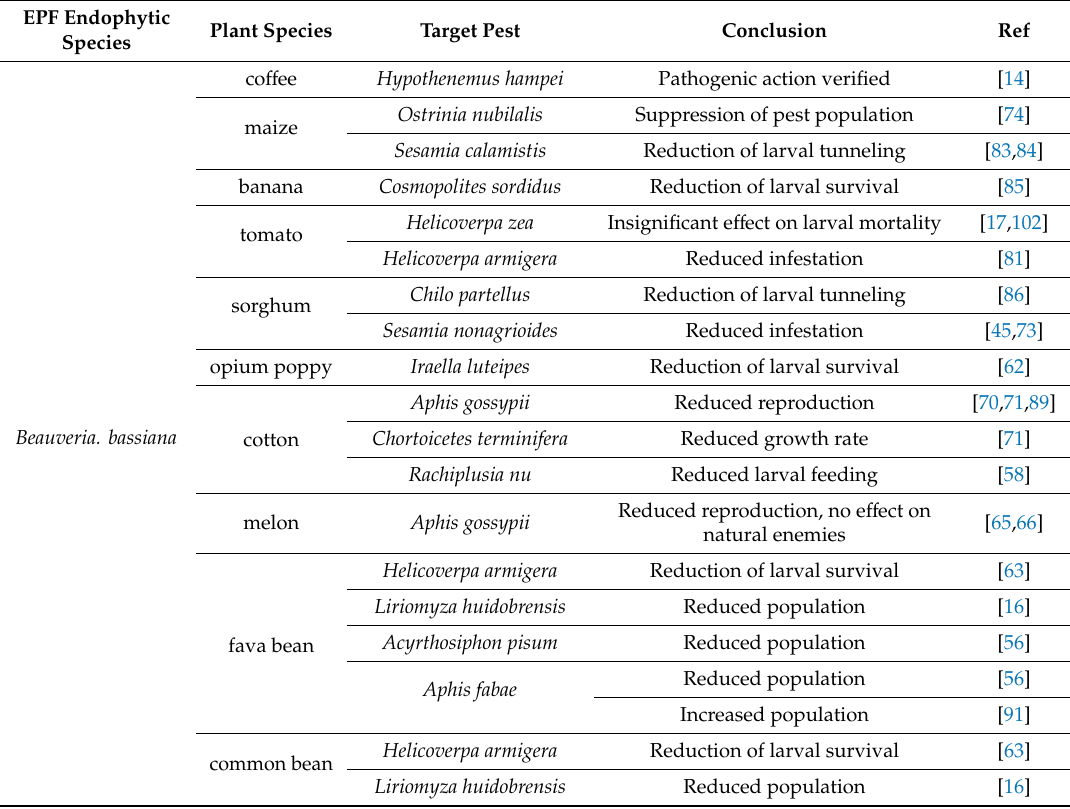
Table A2. Entomopathogenic fungal endophytes evaluated as biocontrol agents against insect pests on various